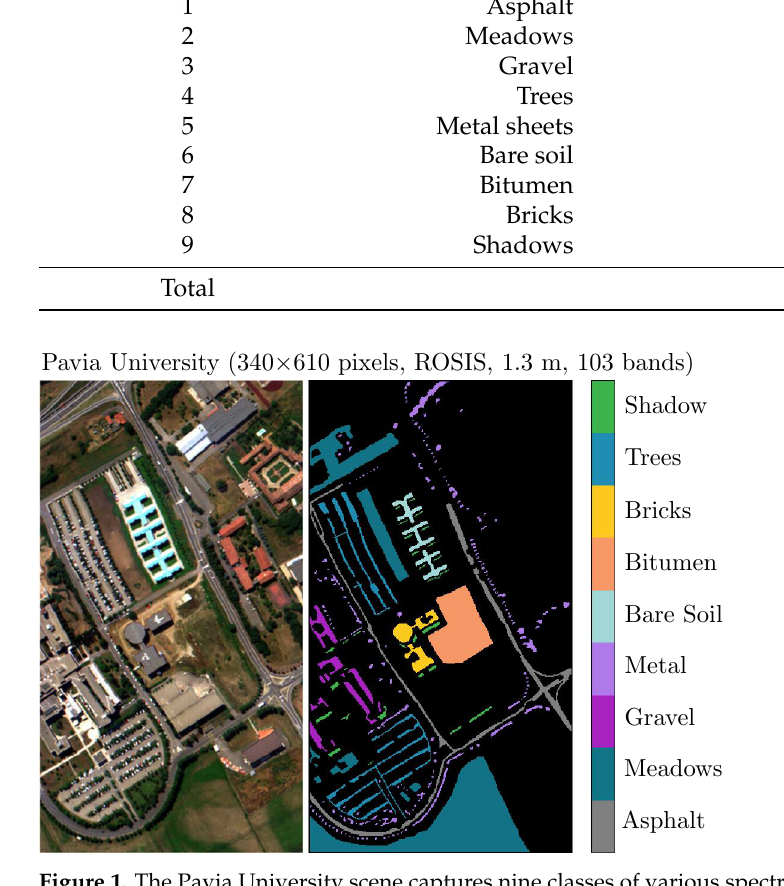
Figure 1. The Pavia University scene captures nine classes of various spectral